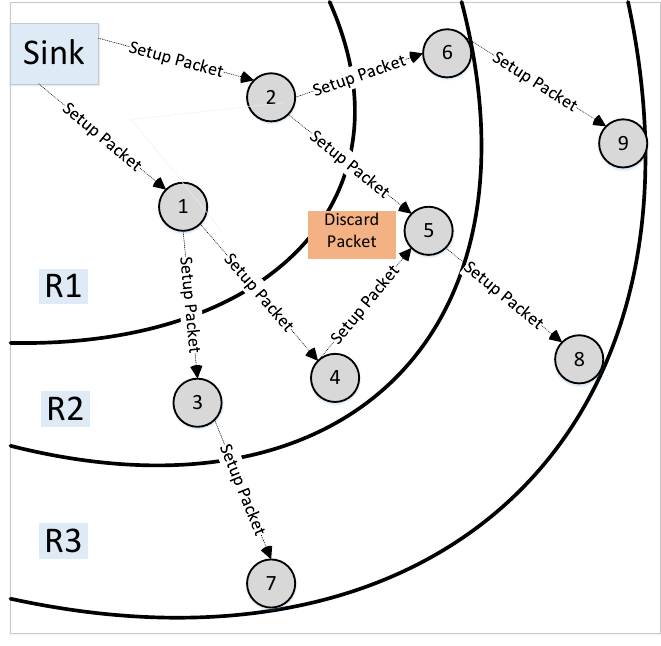
Figure 10. ATAR: Initialization